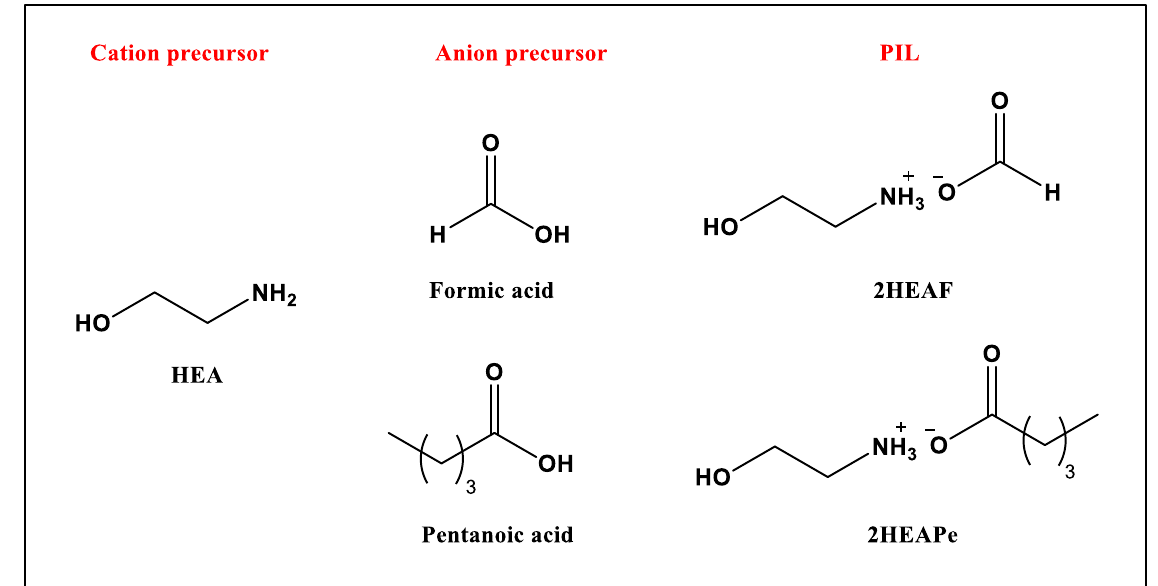
Figure 13. Structure of synthesized PILs and their precursors.